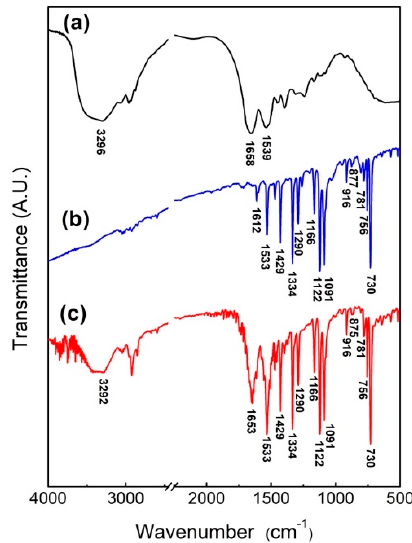
Figure 3. FTIR spectra of ( a ) BSA, ( b ) NiPc, and ( c ) NiPc/BSA. Table 1. Characterized peaks of FTIR of NiPc and BSA [21,23,25–28]. Wavelength (cm − 1 ) Assignment BSA 1539